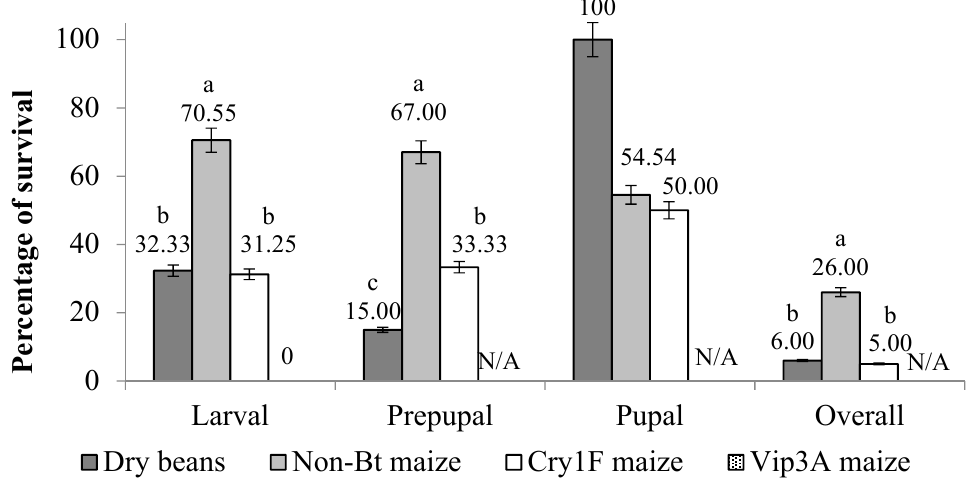
Figure 1. Survival (% ± SE) of S. albicosta immature stages within each stage, from larvae reared on dry beans, non- Bt maize, Cry1F maize, and Vip3A maize (100% mortality) under controlled conditions. Di ff erent letters indicate significant di ff erences between diets within a developmental stage ( p < 0.05). Means comparison based on Tukey’s test. Statistical analyses were not possible for pupal duration due to high mortality.